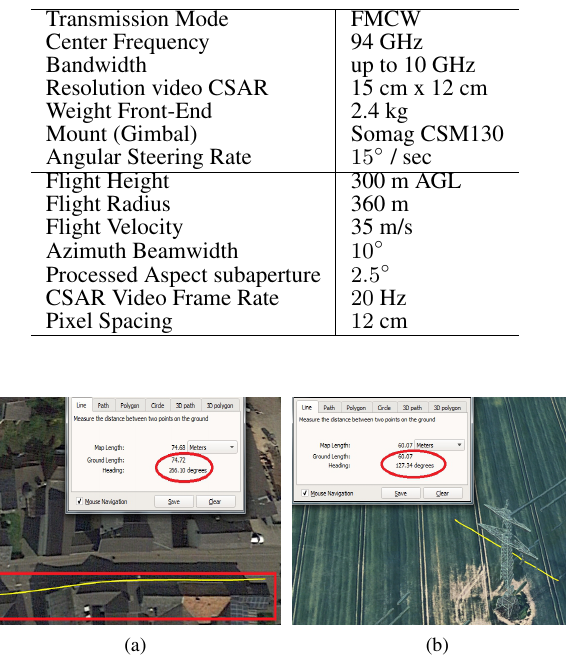
Table 2. CSAR sensor and processing parameters